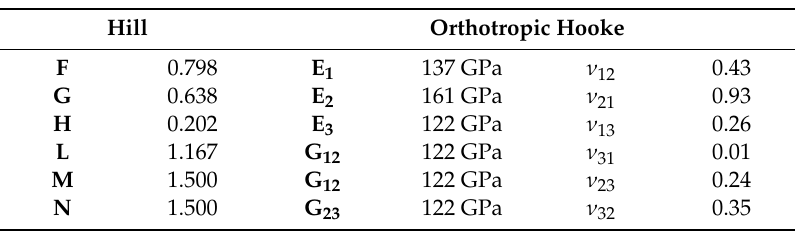
Table 3. Coe ffi cients of the Hill anisotropic yield surface and the orthotropic Hooke’s law tensor for the